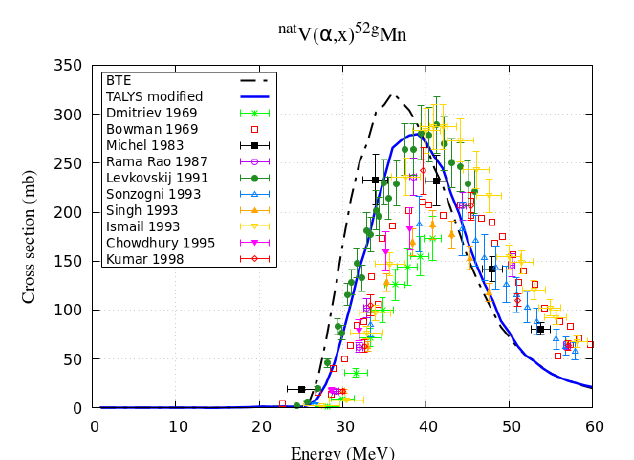
Fig. 1. Experimental data for the cross section of the reaction Nat V(α,x) 52g Mn, together with the optimized TALYS calculation (indicated TALYS modified) and with the BTE.